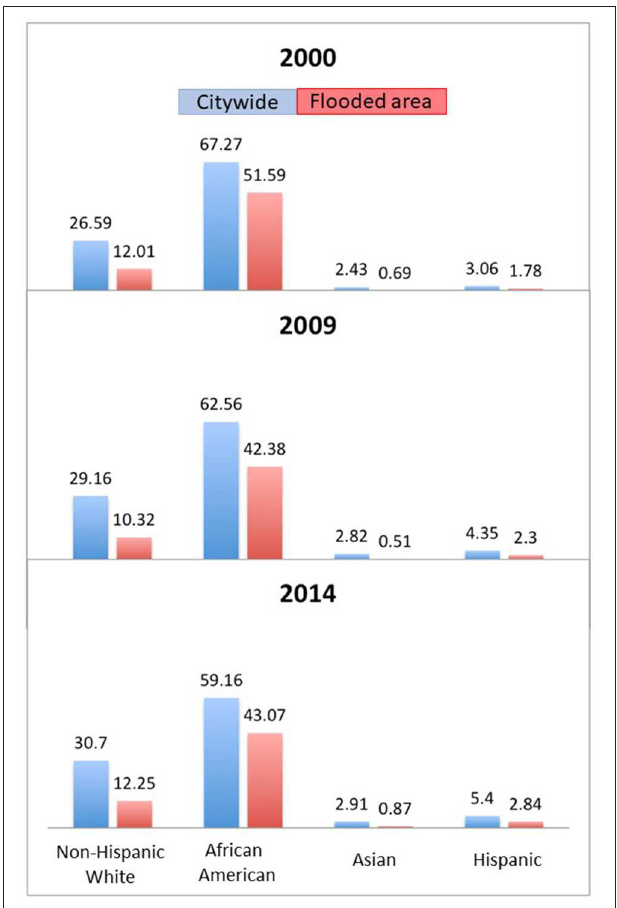
FIGURE 8 | Demographic change in flooded areas over